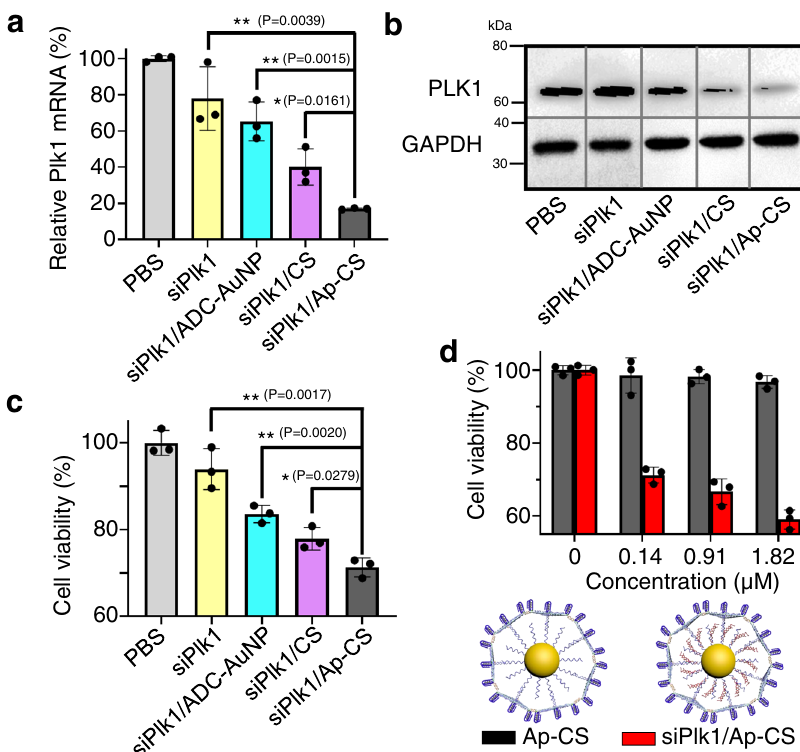
Fig. 6 Capability of siRNA/Ap-CS to knocked down Plk1 mRNA and PLK1 protein expression within MCF-7 cells. The siRNA-targeting Plk1 is abbreviated as siPlk1. After being treated with siPlk1 in different formulations, Plk1 mRNA levels were measured by qPCR ( a ), PLK1 protein expression was analyzed by western blotting ( n = 3) ( b ) and cell viability was test by CCK-8 kit ( c ). The western blot analysis was performed three times independently with similar results. d Cell viability of MCF-7 cells treated with different amounts of siRNA/Ap-CS. The concentration of siRNA in siRNA/Ap-CS ranges from 0 to 1.82 μ M, where the value of 0 indicates that Ap-CS formulation without siRNA was used under identical conditions. The error bar in a , c and d represents the standard deviation (SD), and the measured data are expressed as the means ± SD ( n = 3). * P < 0.05, ** P < 0.01, two-tailed unpaired t